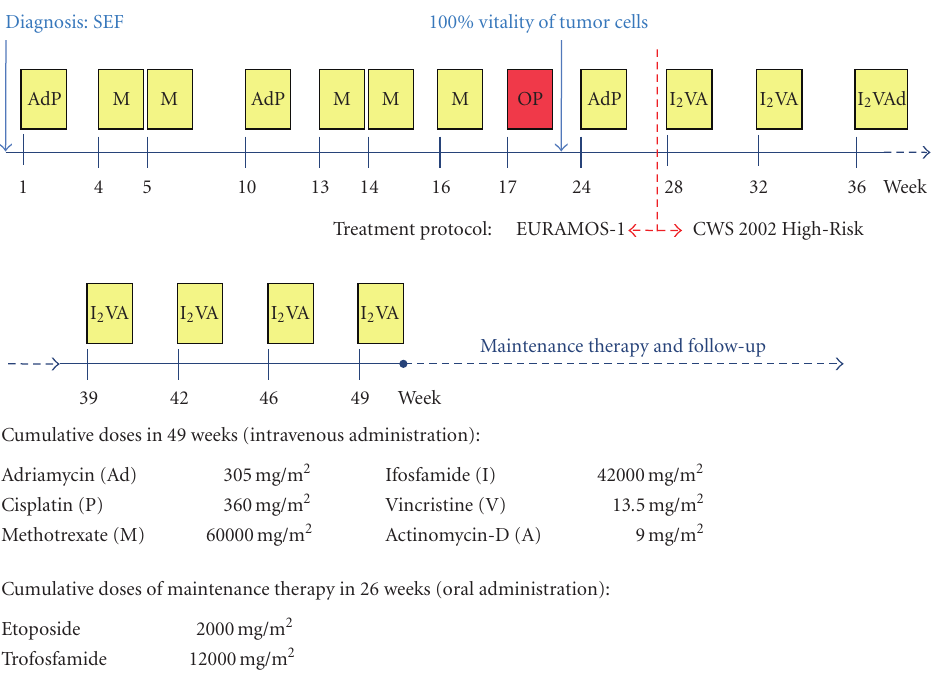
Figure 3: Schematic illustration of the treatment regimen including cumulative dosages of the chemotherapeutic drugs. Each chemotherapy cycle of the main therapy is depicted as a yellow box, and the week when the cycle started is shown below. The time point of surgery and implantation of endoprosthesis is indicated with a red box (OP). The regimens of the maintenance therapy and follow-up are not displayed in